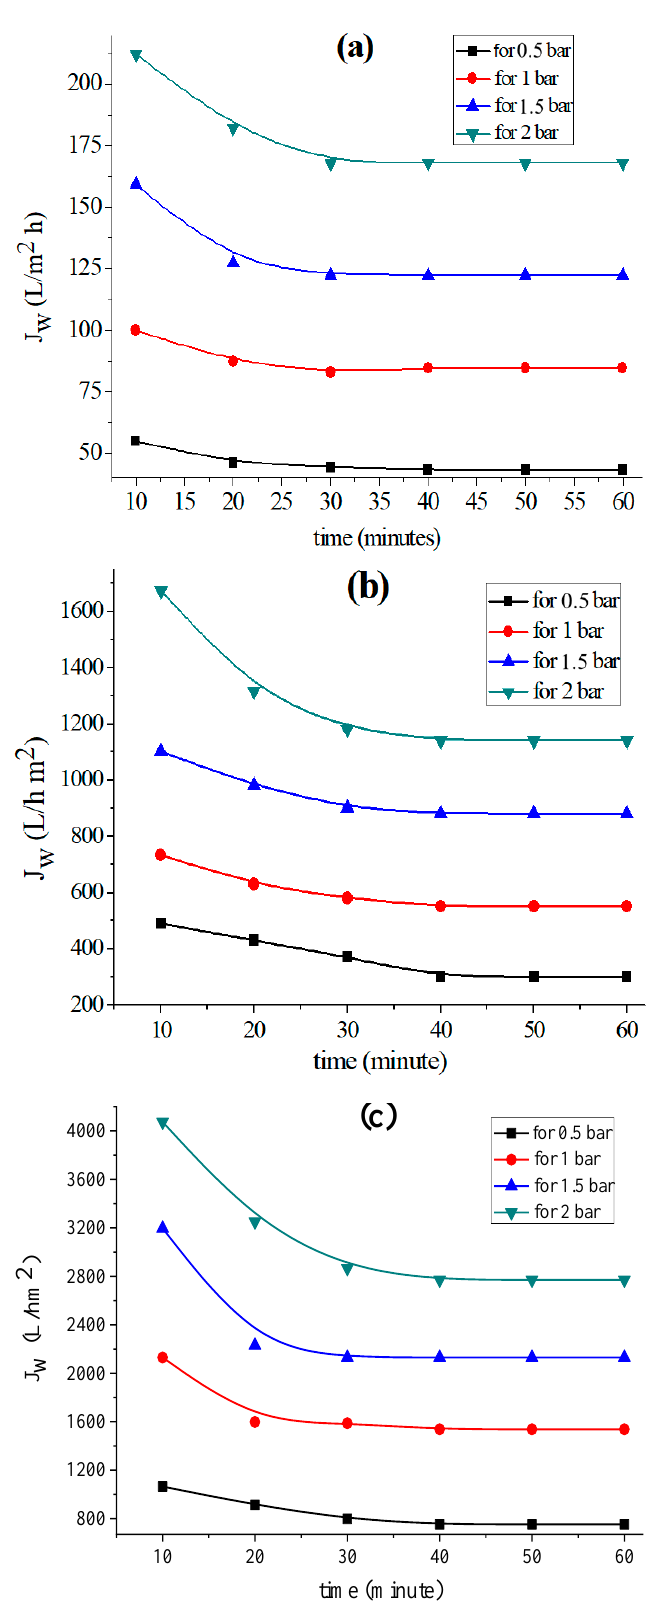
Figure 2. Variation in the permeation flux with distilled water as a function of time for the ( a ) support based on bentonite, ( b ) support based on Aomar clay and ( c ) support based on kaolin. Using the relation (2) [46], we were able to calculate the water permeability (L p ) for the tubular supports that corresponded to each kind of clay via the graphical depiction of the flux fluctuation as a function of applied pressure J w = f(P).